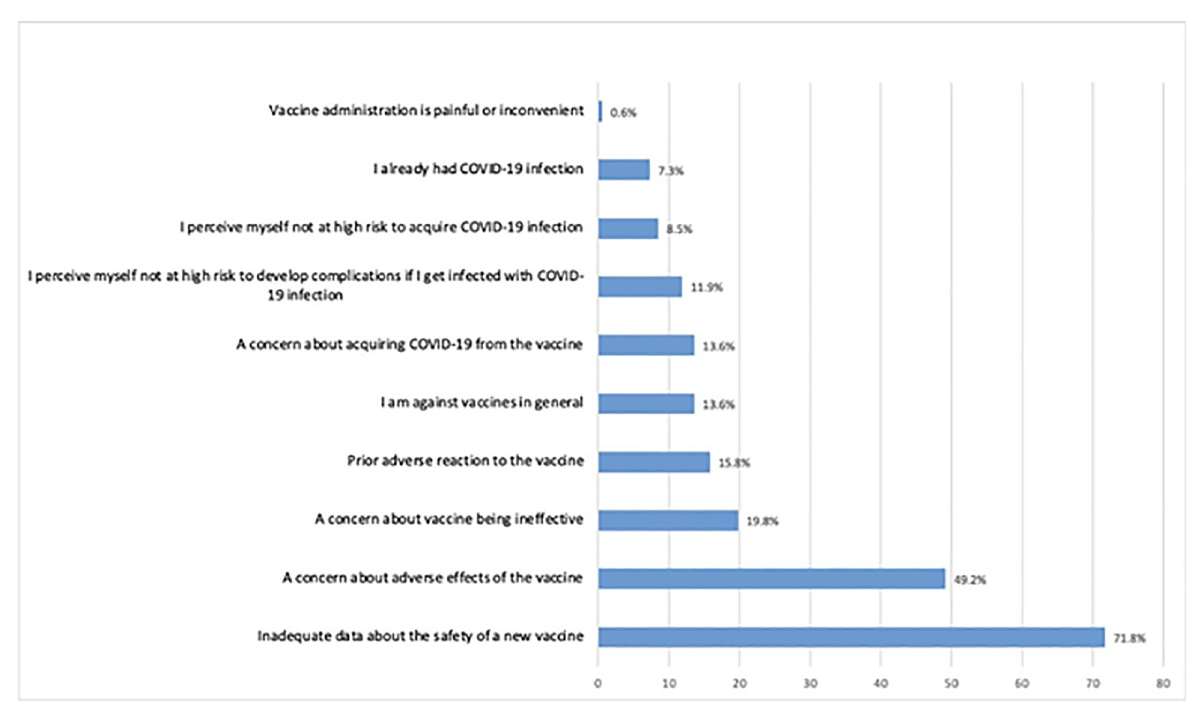
Fig 1. Reasons for unwillingness to receive COVID19 vaccines (N =